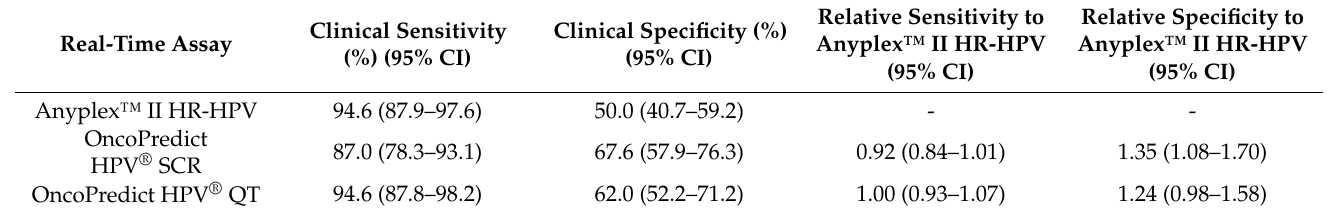
Table 2. Absolute and relative clinical sensitivity and specificity for high-grade cervical